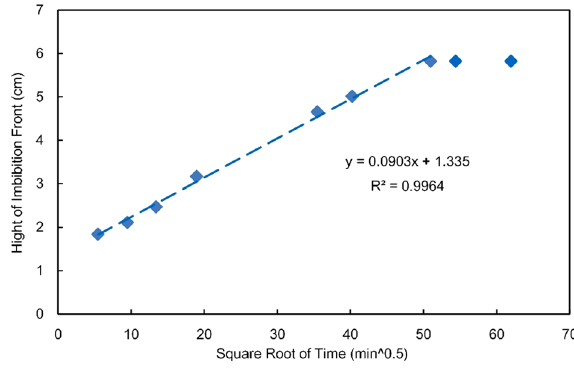
Figure 6. Hight of imbibition front versus the square root of time.